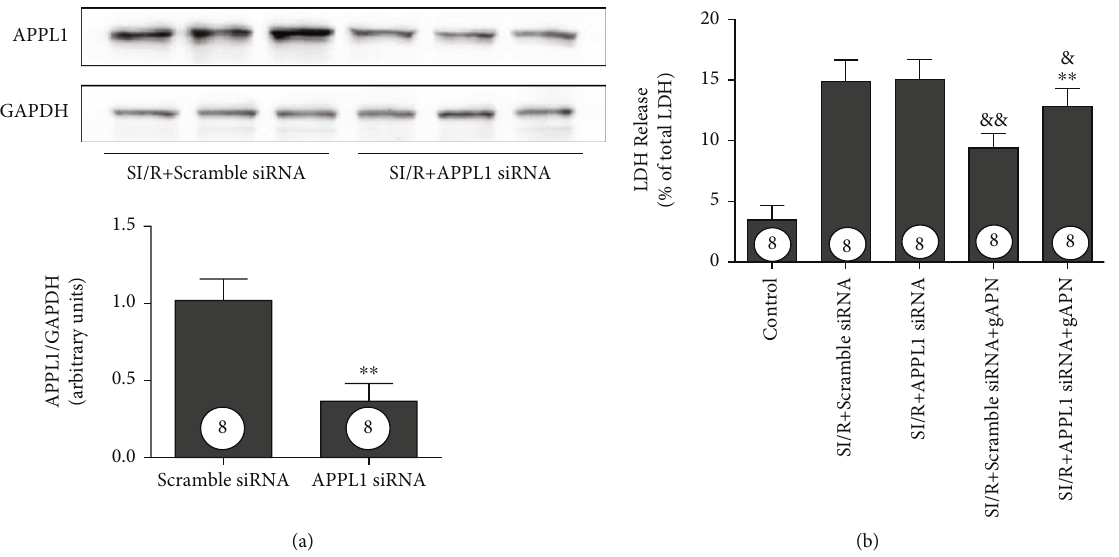
Figure 6: APPL1 stealth RNAi blunted anti-cell death action of gAPN in neonatal cardiomyocytes. (a) Western blot analysis for APPL1. APPL1 expression was compared for groups with or without APPL1 siRNA. (b) LDH release. Cell death was determined by detection of LDH release. ∗∗ P < 0 : 01 vs. the same treatment group without APPL1 siRNA. & P < 0 : 05 ; && P < 0 : 01 vs. the same treatment group without gAPN.